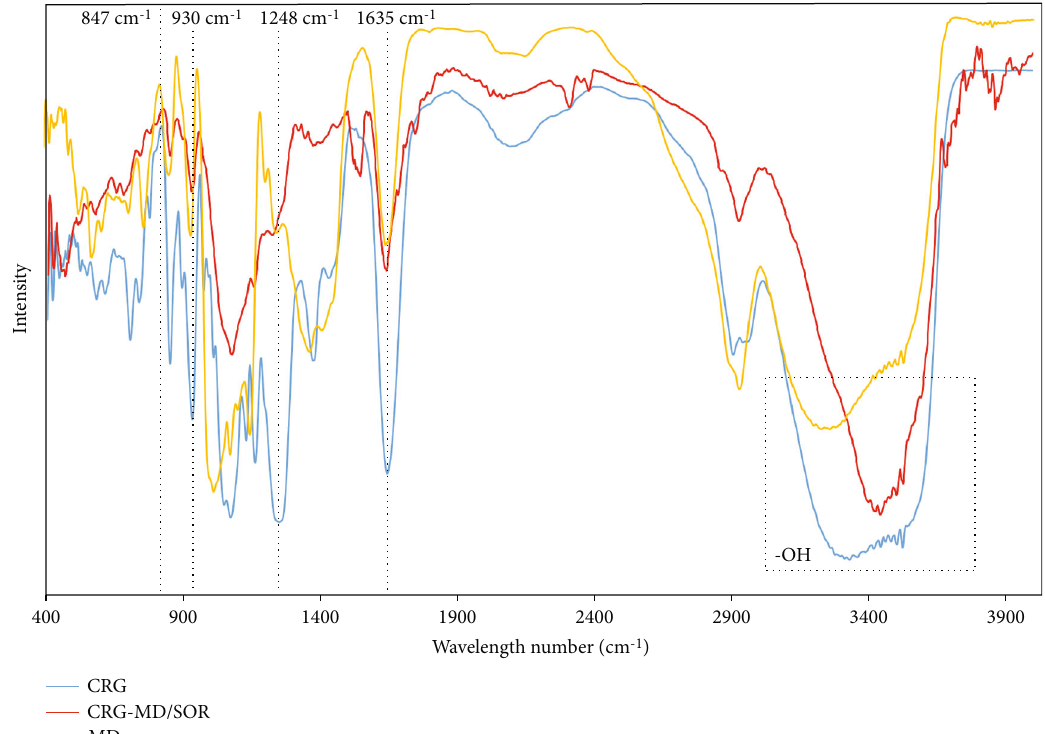
Figure 1: FTIR spectra of CRG (carrageenan) powder, MD (maltodextrin) powder, and CRG-MD/SOR (carrageenan-maltodextrin/sorbitol) capsule.